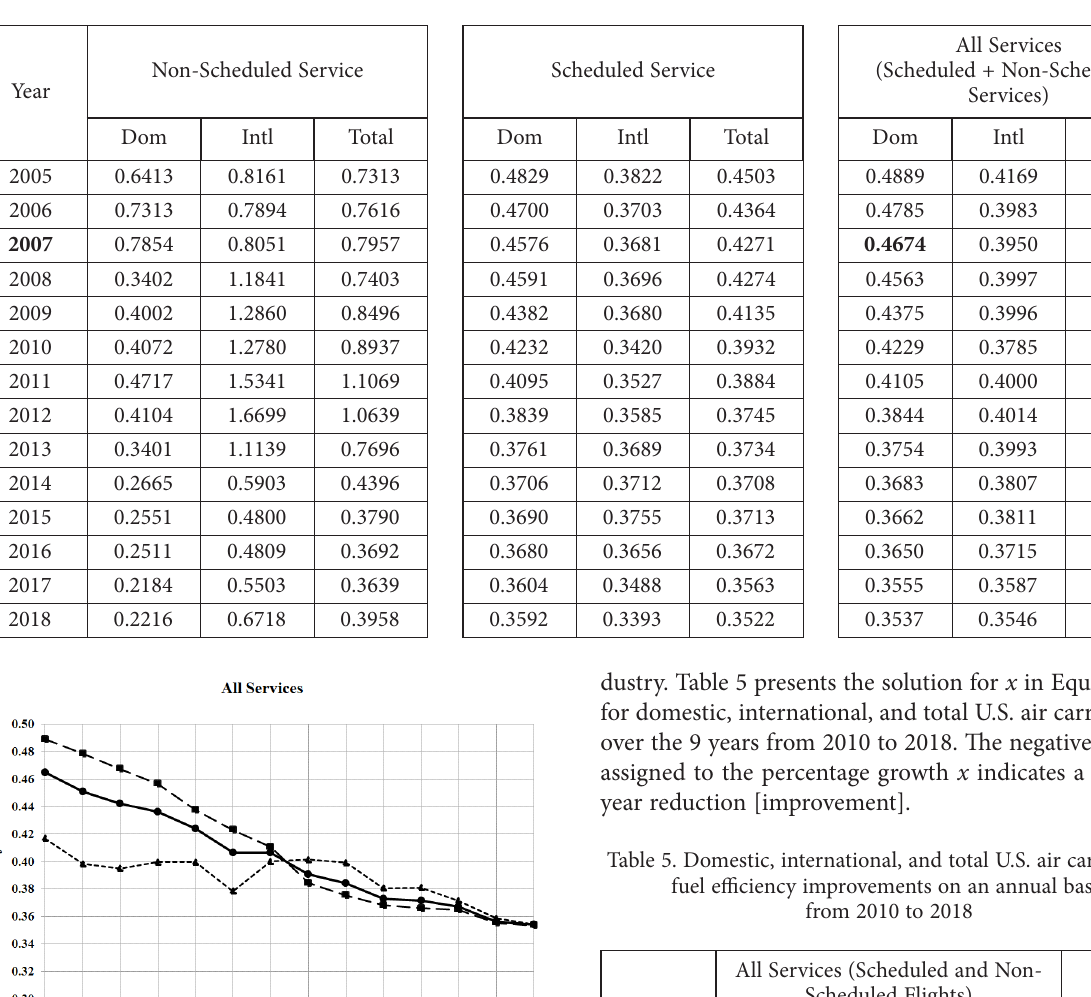
Table 4. Fuel Efficiency Values, η (Litres/RTK), for U.S. air carriers on an annual basis